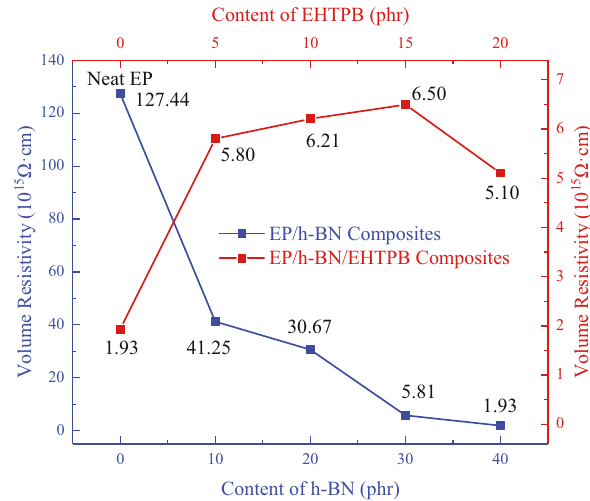
Figure 10: Volume resistivity of prepared